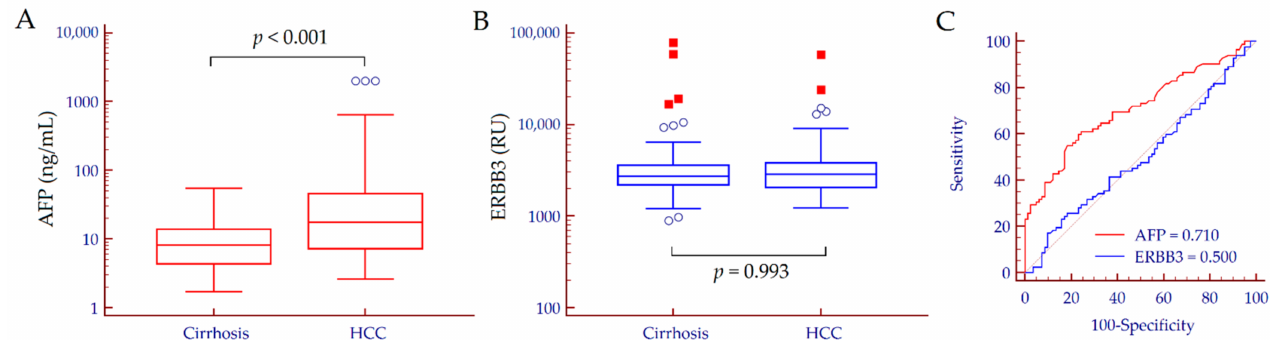
Figure 1. AFP ( A ) and ERBB3 ( B ) serum values in patients with cirrhosis and those with HCC and the corresponding receiver operating characteristic (ROC) curves ( C ). Hollow circles indicate values that are smaller than the lower quartile minus 1.5 times the interquartile range, or larger than the upper quartile plus 1.5 times the interquartile range; red squares indicate values that are smaller than the lower quartile minus 3 times the interquartile range, or larger than the upper quartile plus 3 times the interquartile range. p values were calculated by the Mann–Whitney test. Abbreviations: alpha-fetoprotein (AFP), area under the curve (AUC), epidermal growth factor receptor 3 (ERBB3), arbitrary REAAD™ Units (RU).